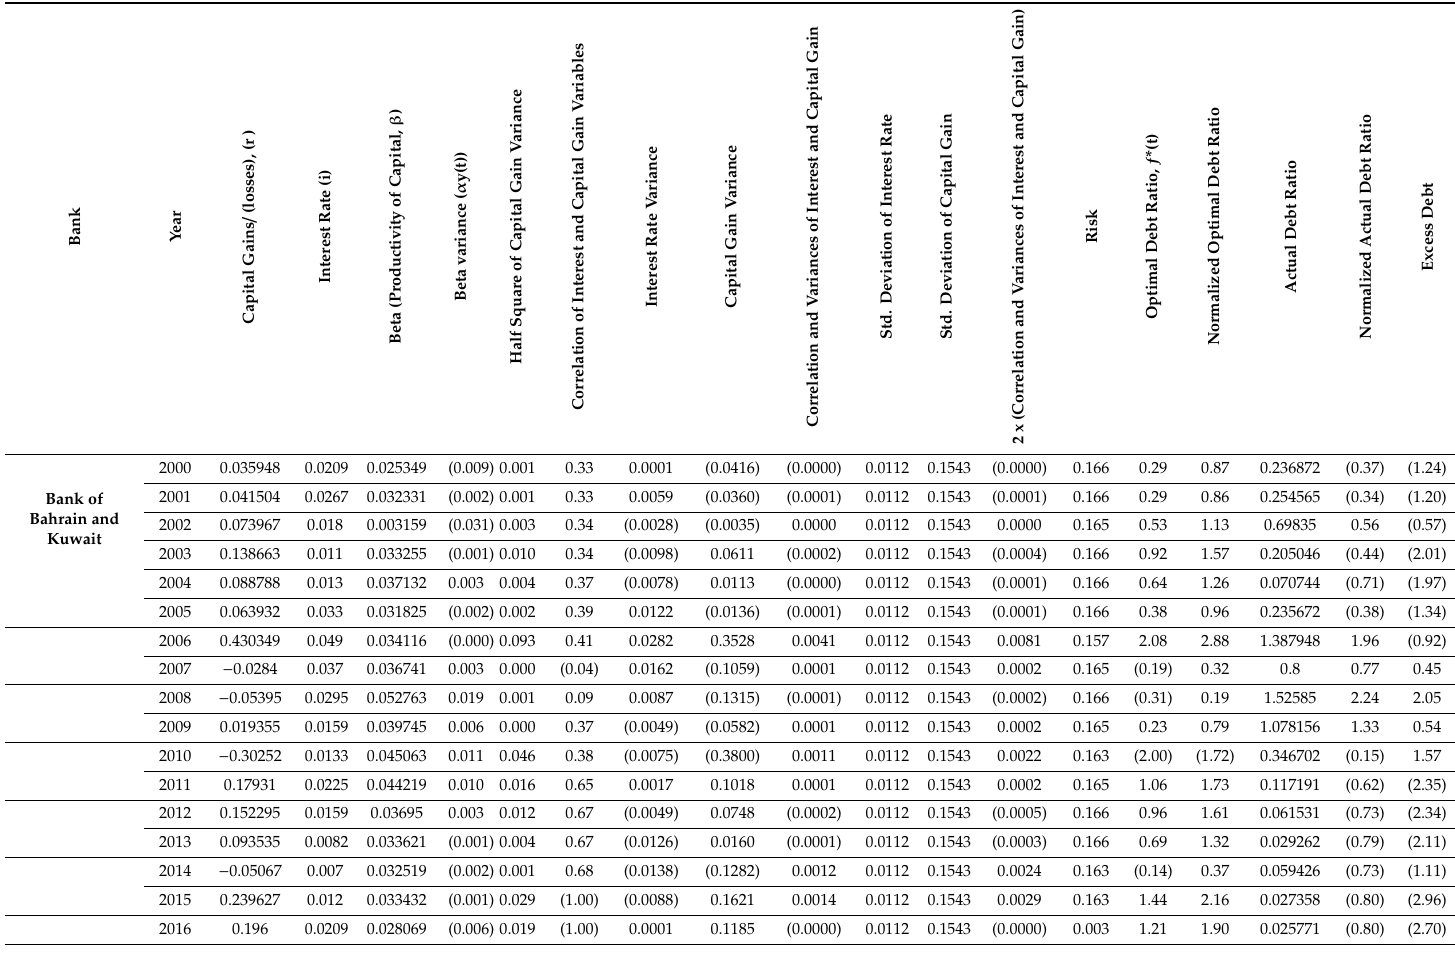
Table A2. Calculations of Optimal and Excess Debt: Bank of Bahrain and